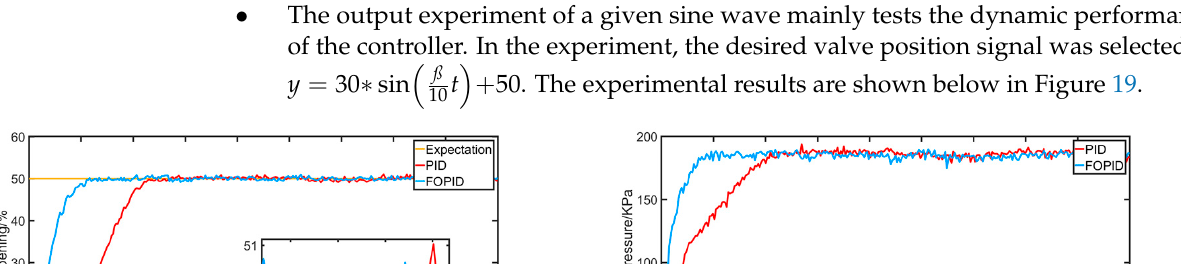
Figure 17. Experimental equipment and devices.